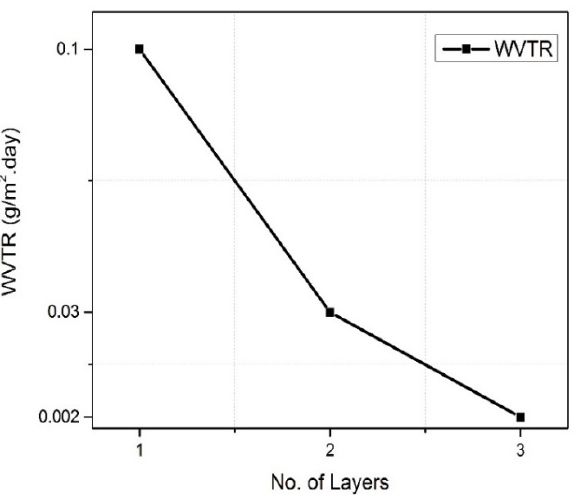
Figure 8. Barrier properties of multilayers of PHPS coated on PET substrate, each layer cured with simultaneous deep UV irradiation and heat.